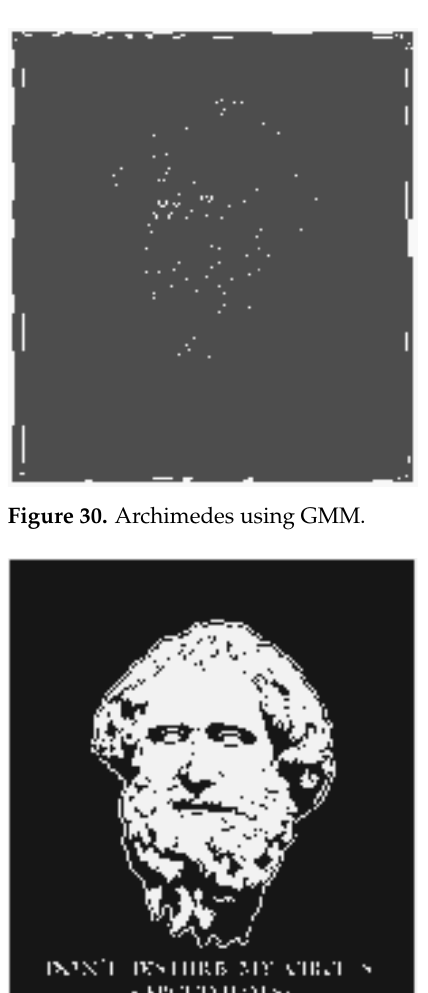
Figure 31. Archimedes using FCM.